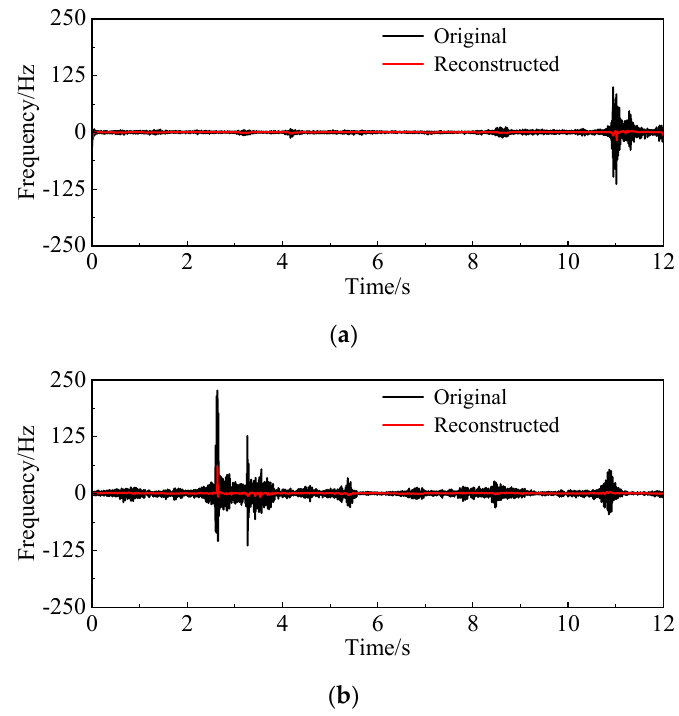
Figure 14. Instantaneous frequency distribution: ( a ) None; ( b )